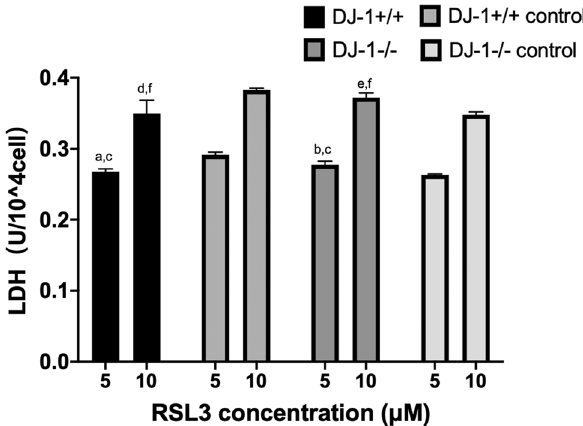
Figure 9. Effect of RSL3 on the release rate of LDH in transfected BeWo cells. ( a – c ) Effect of RSL3 (5 μM) on the release rate of LDH in transfected BeWo cells. ( a ) Compared to the DJ‑1 + / + negative control group, the mortality rate of BeWo cells in the DJ‑1 + / + group decreased significantly (P < 0.001). ( b ) Compared to the DJ‑1 −/− negative control group, the mortality rate of BeWo cells in the DJ‑1 −/− group increased significantly (P = 0.001). ( c ) Compared to the DJ‑1 −/− group, the mortality rate of BeWo cells in the DJ‑1 + / + group decreased significantly (P = 0.012) (biological replicates number: 2). ( d – f ) Effect of RSL3 (10 μM) on the release rate of LDH in transfected BeWo cells. ( d ) Compared to the DJ‑1 + / + negative control group, the mortality rate of BeWo cells in the DJ‑1 + / + group decreased significantly (P = 0.004). ( e ) Compared to the DJ‑1 −/− negative control group, the mortality rate of BeWo cells in the DJ‑1 −/− group increased significantly (P = 0.021). ( f ) Compared to the DJ‑1 −/− group, the mortality rate of BeWo cells in the DJ‑1 + / + group decreased significantly (P = 0.028) (biological replicates number: 2). Differences among groups were compared by single factor analysis of variance (ANOVA) the type of post hoc test used